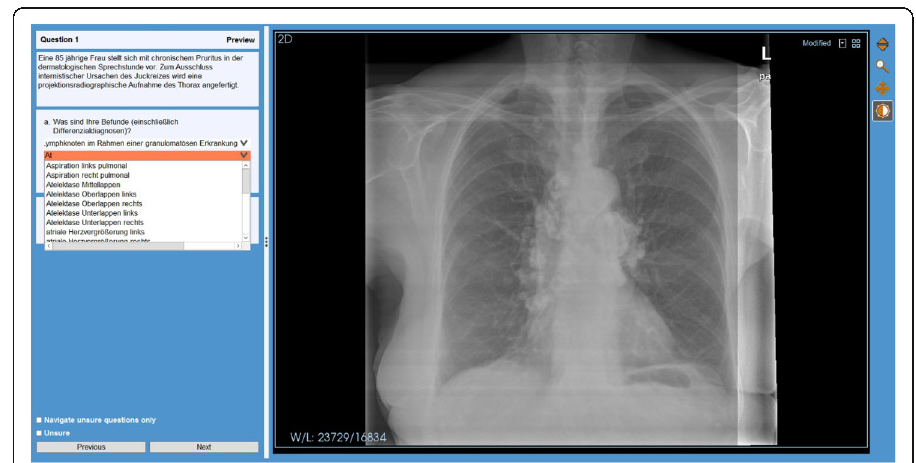
Fig. 1 Individual computer task in VQuest program with multiple-choice question in which answers